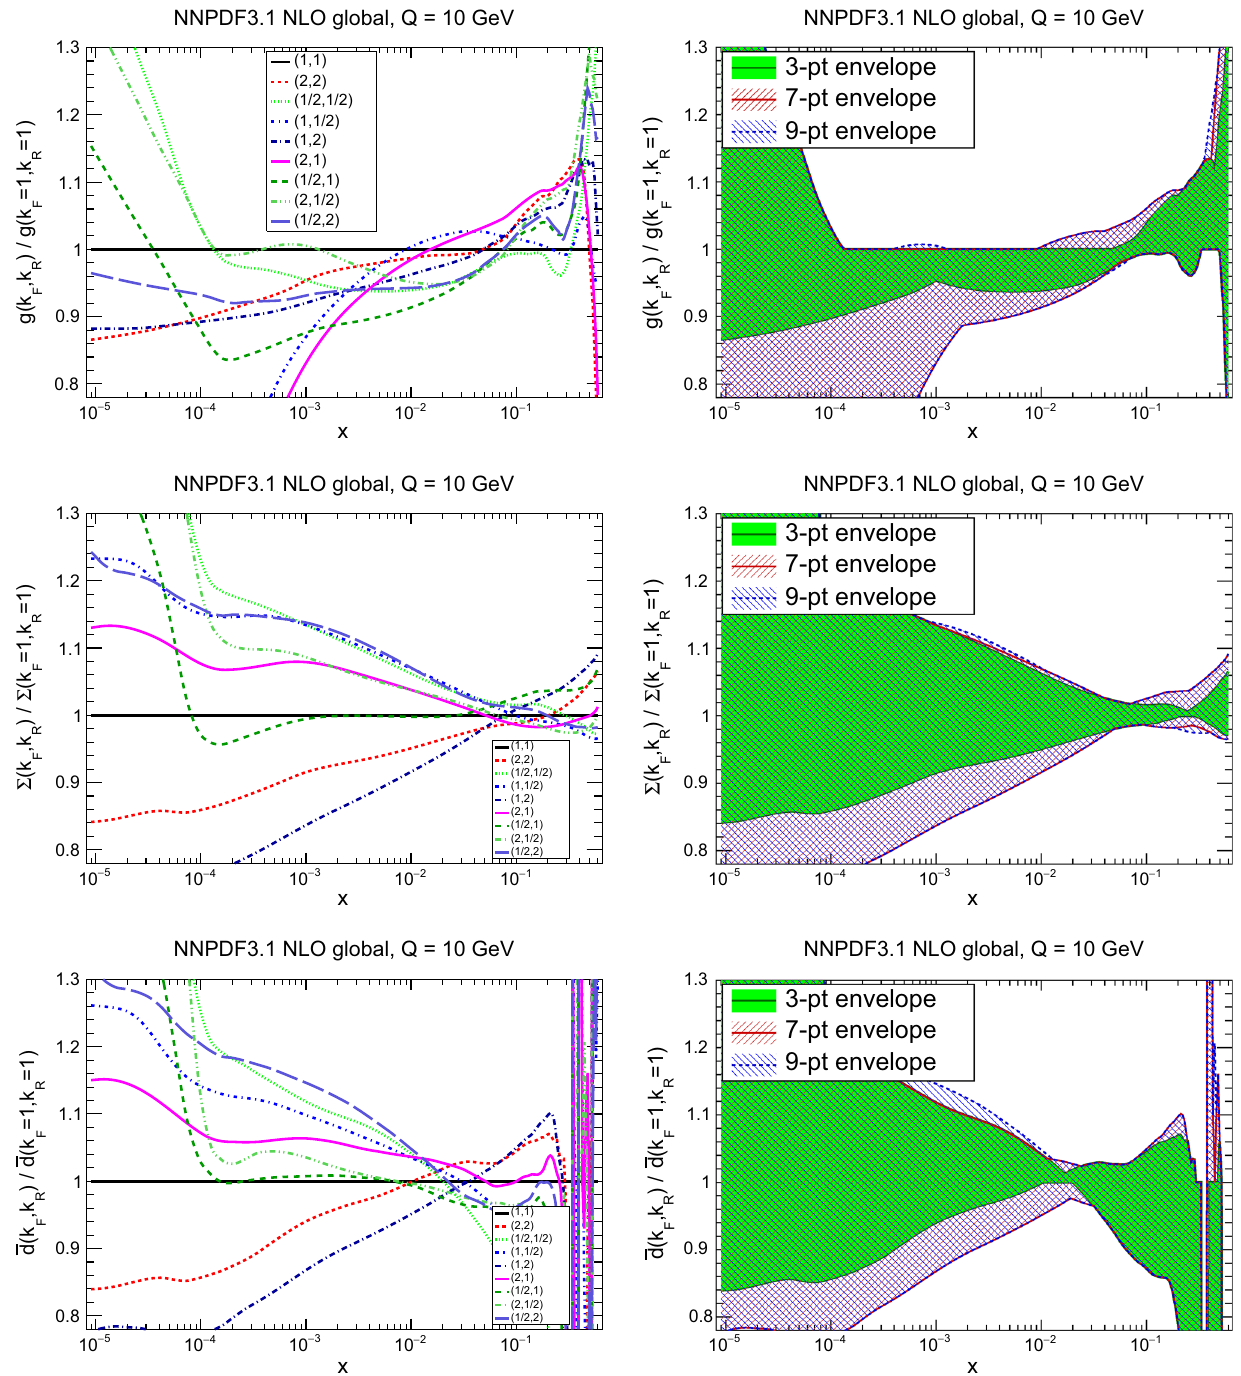
Fig. 25 Left: same as Fig. 24 (left) for global PDF sets. Right: Envelope of scale variations computed using various prescriptions (see text) ) leads to a much larger χ 2 than The scale choice ( 2 , 1 2 any other choice. This choice, which involves a large scale ratio, is typically omitted when estimating scale uncertainties from an envelope prescription. Note however that the recip- , 2 ) , which is also usually discarded for the rocal choice ( 1 2 same reason, leads to a χ 2 which is not particularly